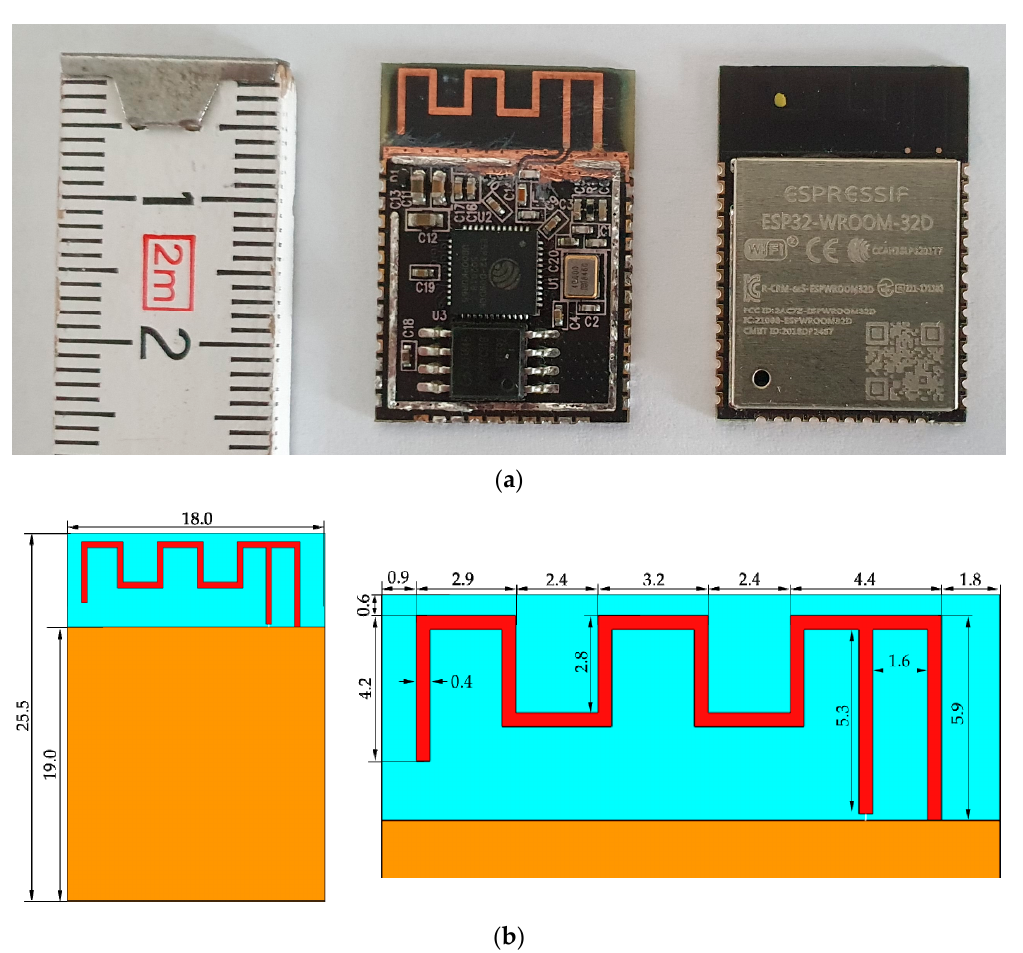
Figure 4. ( a ) View of physical wireless communication module (ESP32-WROOM-32 radiofrequency (RF) module) and ( b ) dimensions (in millimetres) of developed numerical model of meandered inverted-F antenna (MIFA) ( right ) and dimensions of substrate and ground ( left ) of RF module used in Internet of Things (IoT) wearable devices.